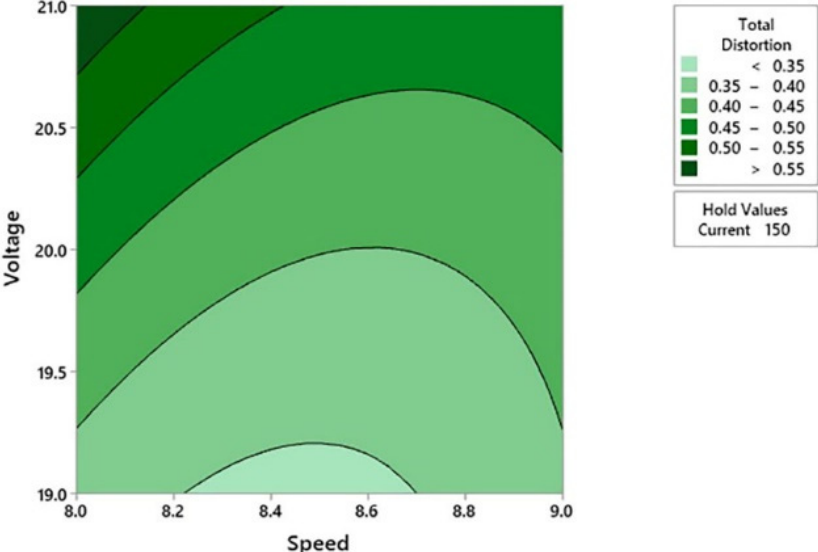
Figure 8. Contour Plot of Distortion vs. Current, Speed.